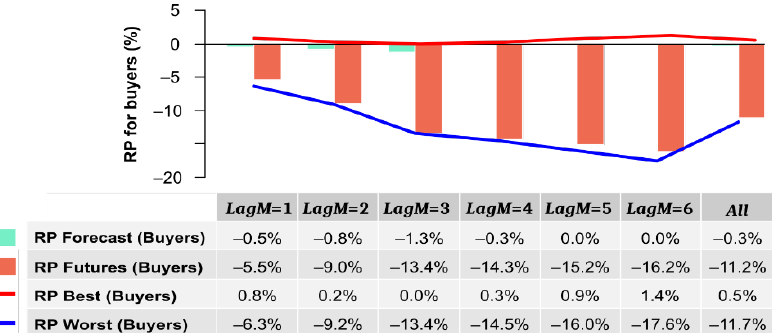
Figure 7. Risk Premium for buyers.